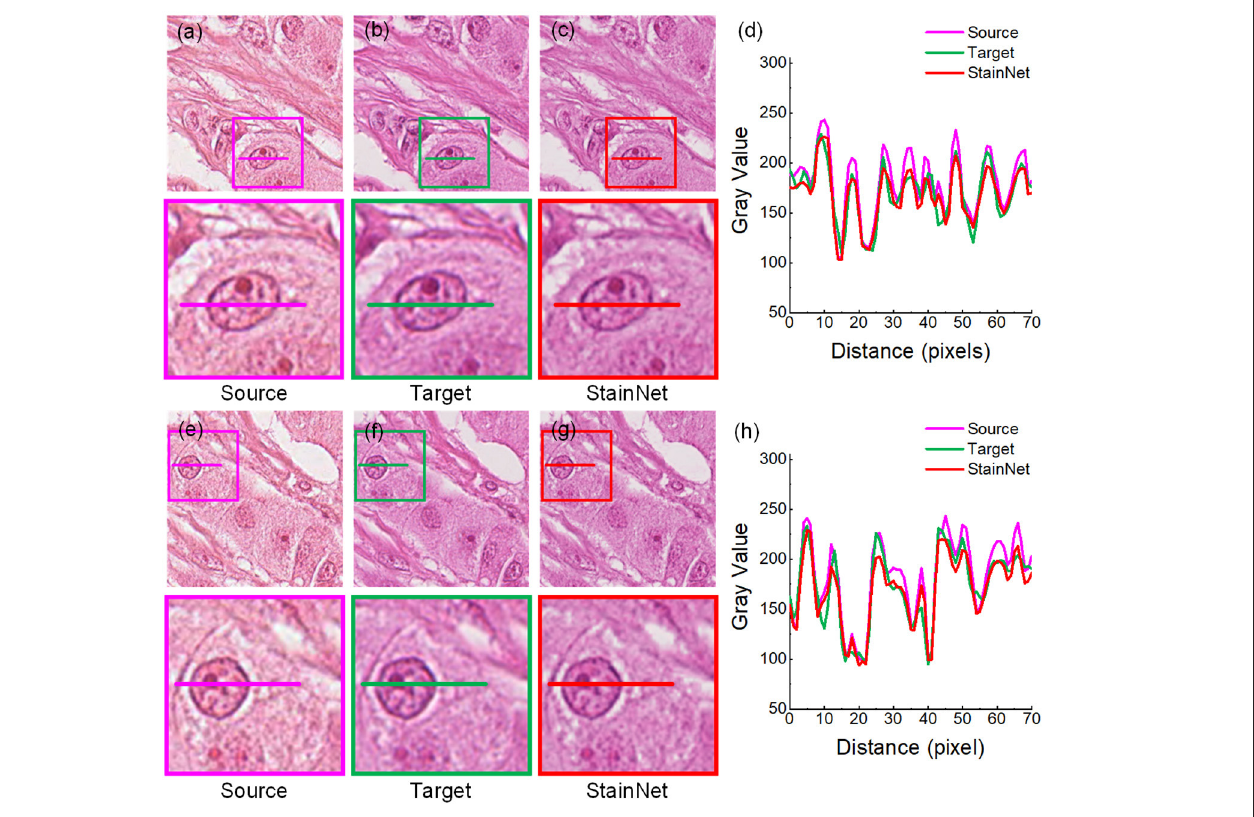
FIGURE 3 | StainNet normalization effects on the histopathology image. The source images, the target images, and the normalized images by StainNet are shown in (a,e) (b,f) , and (c,g) , respectively. The image in the box is enlarged below. Gray value profiles of the lines on (a–c) are shown in the line chart (d) , and the lines in (e–g) are shown in the line chart (h) .